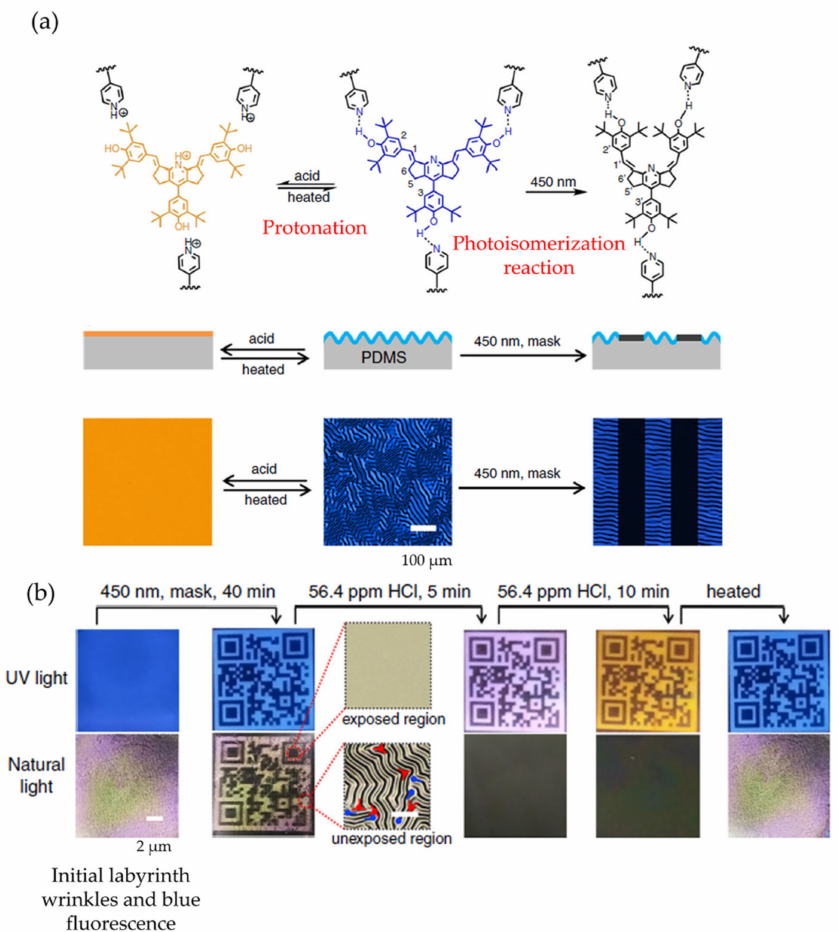
Figure 5. ( a ) Strategy to produce dynamic wrinkled patterns with tunable fluorescence using P4VP- nBA-S/DSP-OH, characterized by laser scanning confocal microscopy (LSCM), and ( b ) photographs of QR code based on wrinkled and fluorescent patterns for anti-counterfeiting applications. Repro- duced with permission from reference [44]. Copyright 2020, Springer